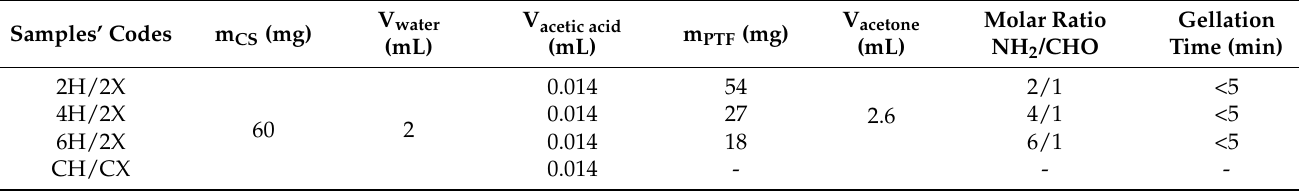
Table 2. The receipt for obtaining the hydrogels and corresponding xerogels, as well as their codes.